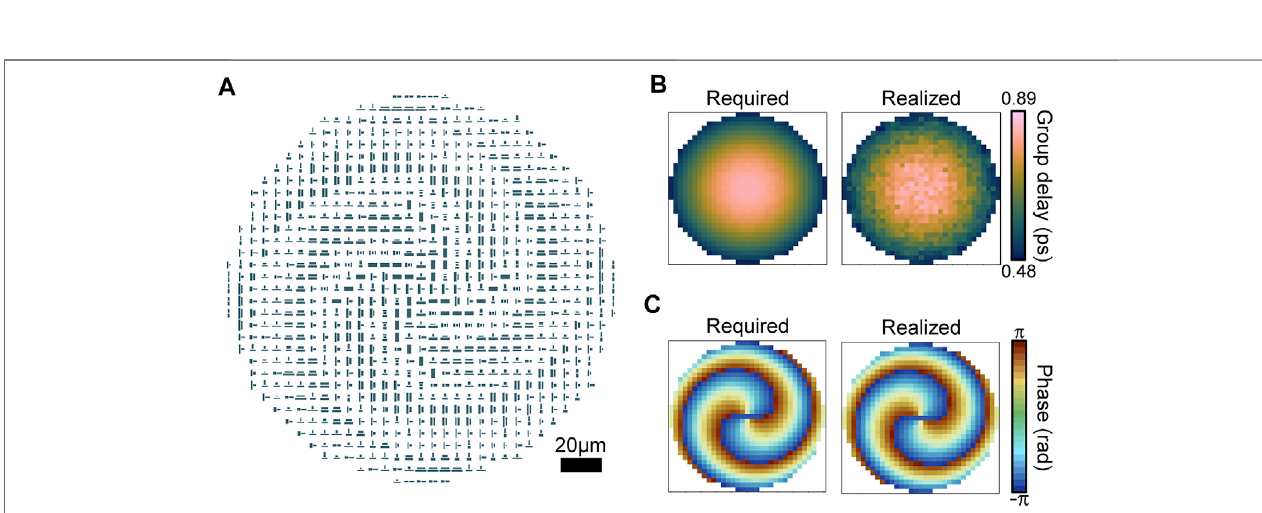
FIGURE6| Designofthebroadbandachromaticandpolarizationinsensitive fl atFOVgenerator. (A) Layoutofthe fl atFOVgenerator. (B) Requiredgroupdelay(left) and realized group delay (right) of the fl at FOV generator at each coordinate. (C) Required phase (left) and realized phase (right) of the fl at FOV generator at each